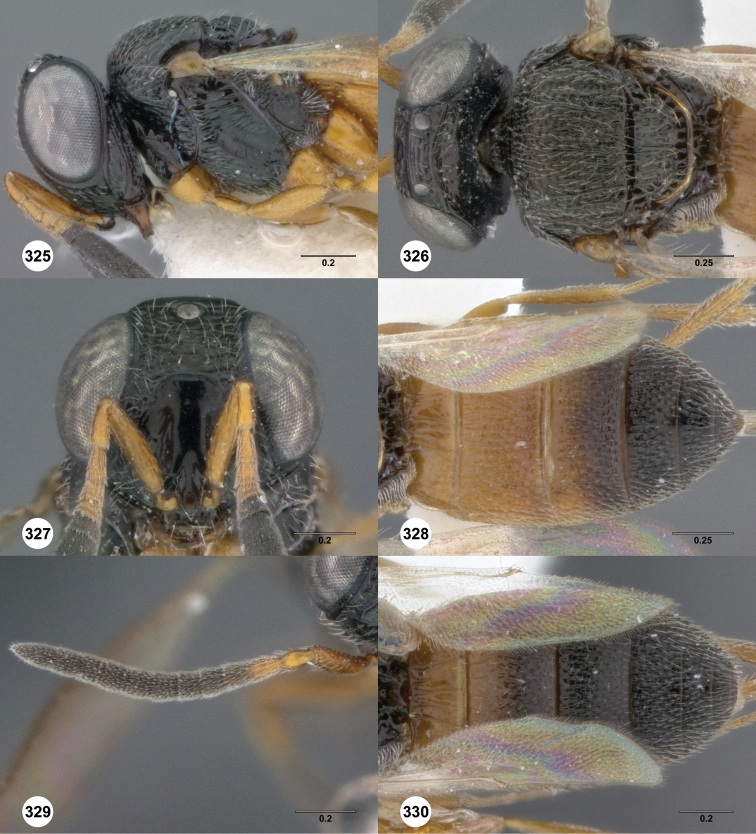
Oxyscelio shakespearei (Girault), female (OSUC 442355) 325 Head and mesosoma, lateral view. Female (OSUC 227547) 326 Head and mesosoma, dorsal view 327 Head, anterior view 328 Metasoma, dorsal view. Paratype male (OSUC 227546) 329 Antenna 330 Metasoma, dorsal view. Morphbank89